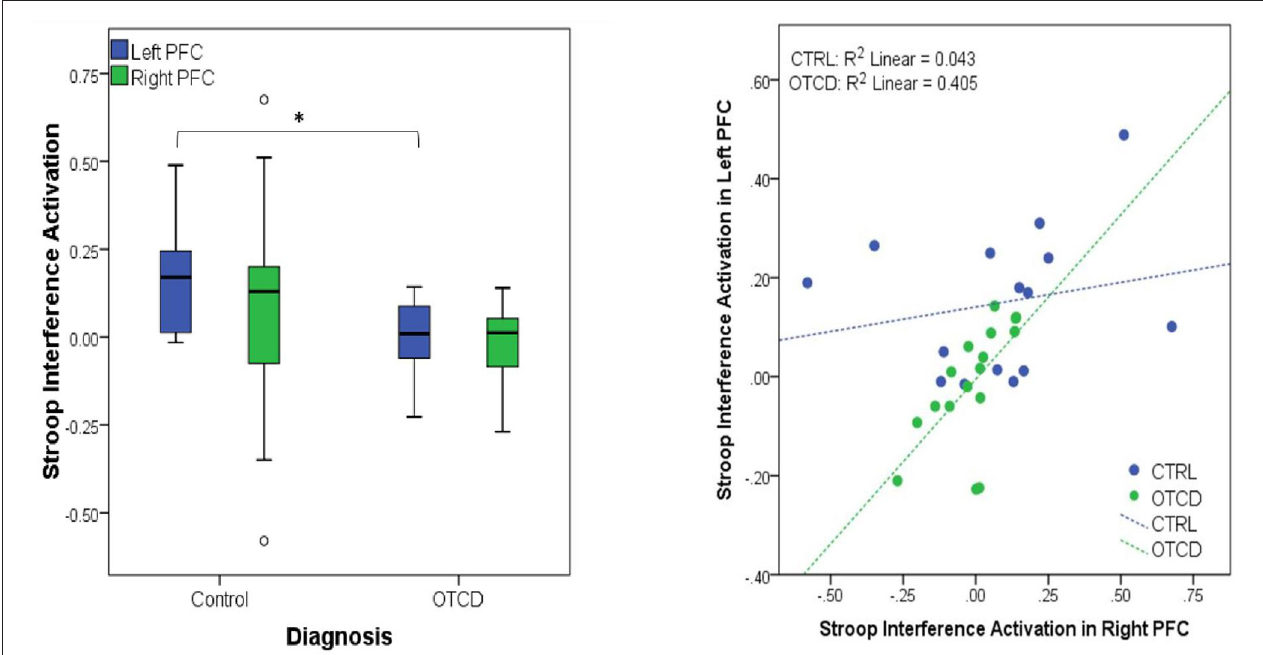
FIGURE 6 | (Left) Significant activation difference between controls and participants with OTCD in Left PFC. (Right) Significant correlation between left and right PFC in OTCD participants (https://www.sciencedirect.com/science/article/abs/pii/S1096719219307310).